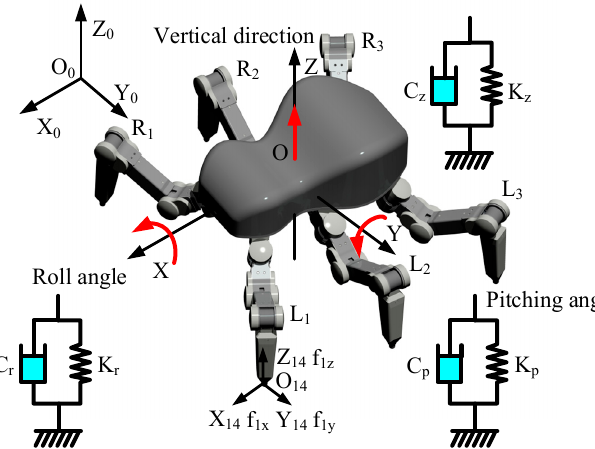
Figure 9. Force equilibrium model of the hexapod robot.